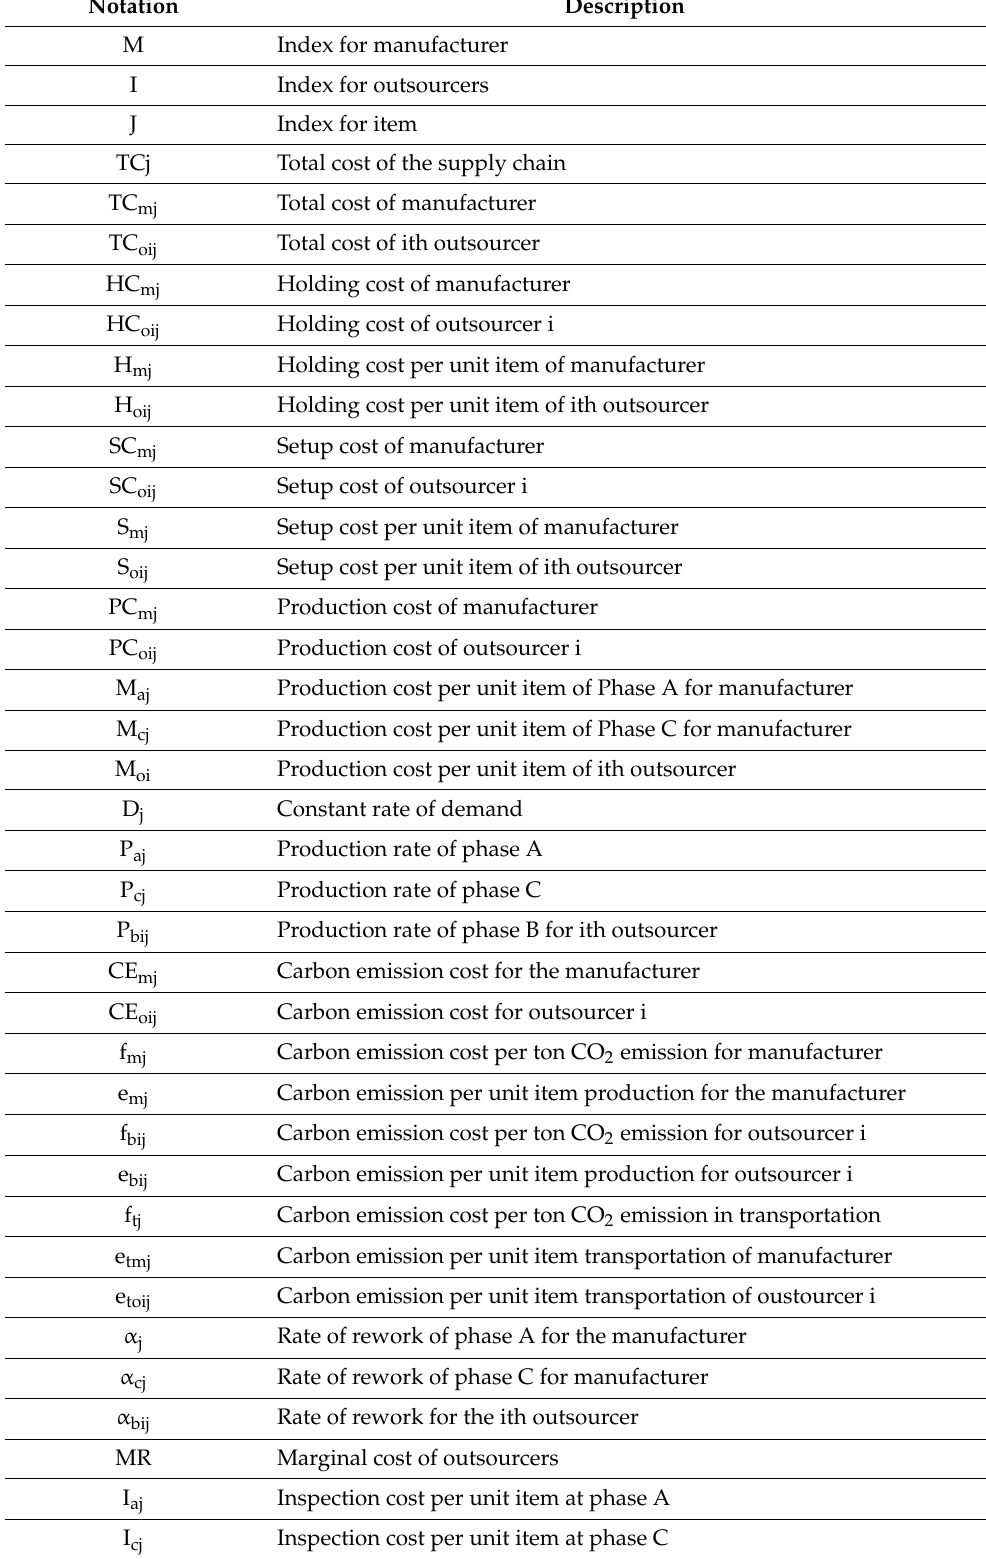
Table 2. Notations used in this